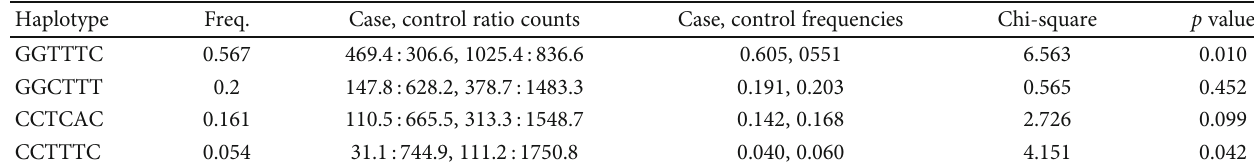
Table 5: Haplotypes of ACMP and